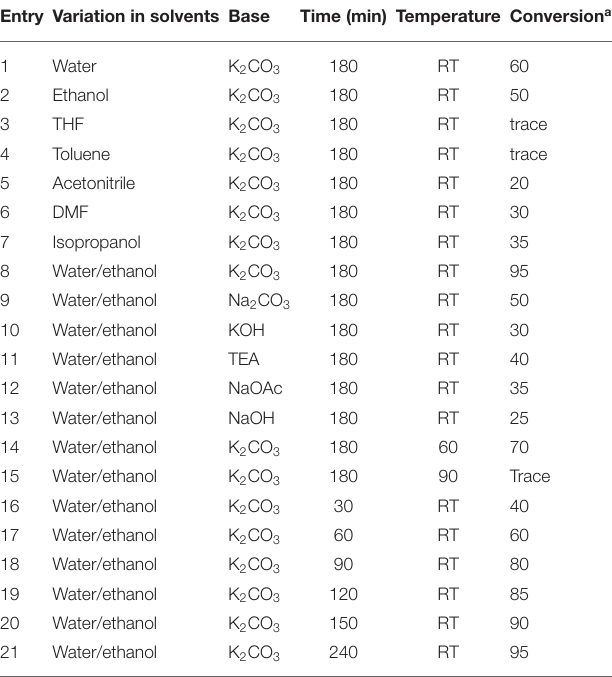
TABLE 2 | Optimization study for variation of various solvents, base, time and temperature in the synthesis of diphenylaceteylenes.